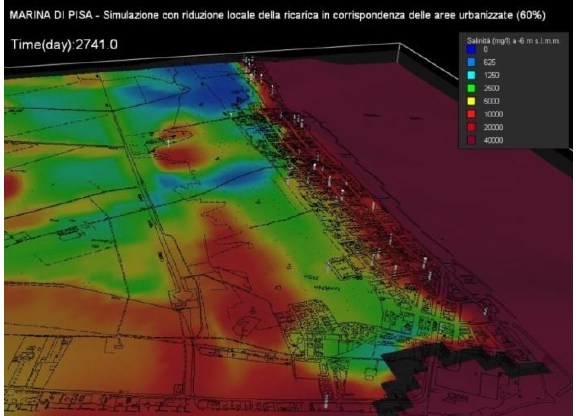
Figure 4. Scenario with local reduction of the charge for urban areas in the Marina di Pisa area (3D view obtained by Modflow 3D Visual Explorer). Salinity distribution at -6m m a.s.l. (mg/l)